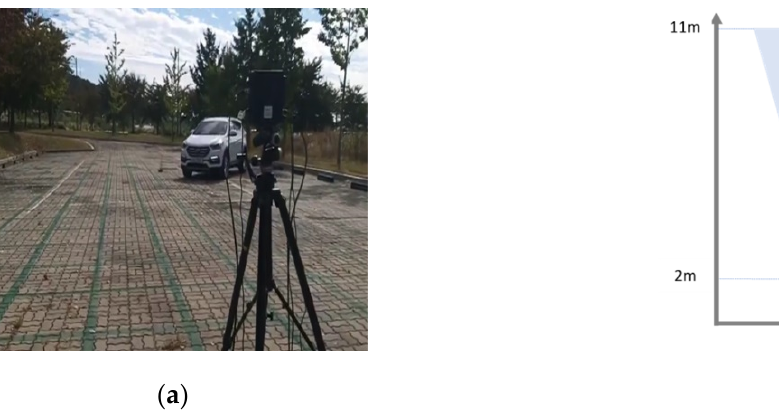
Figure 5. Experiment environment and object movement path: ( a ) experiment environment; ( b ) object movement path.